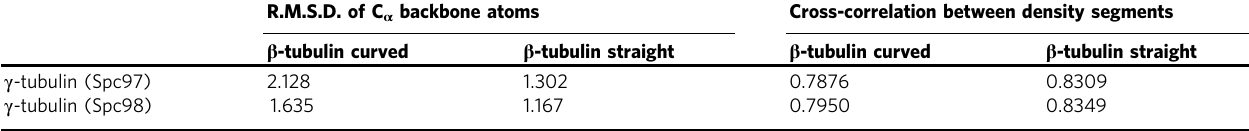
Table 2 Structural comparison between γ -tubulin and β -tubulin in two different